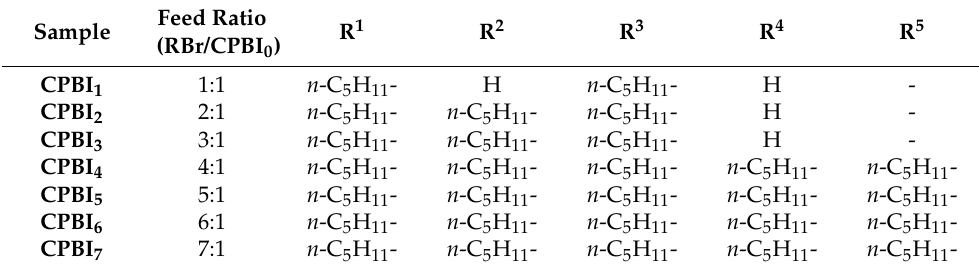
Table 1. The effects of different feed ratios on the basic structure of serial CPBI n